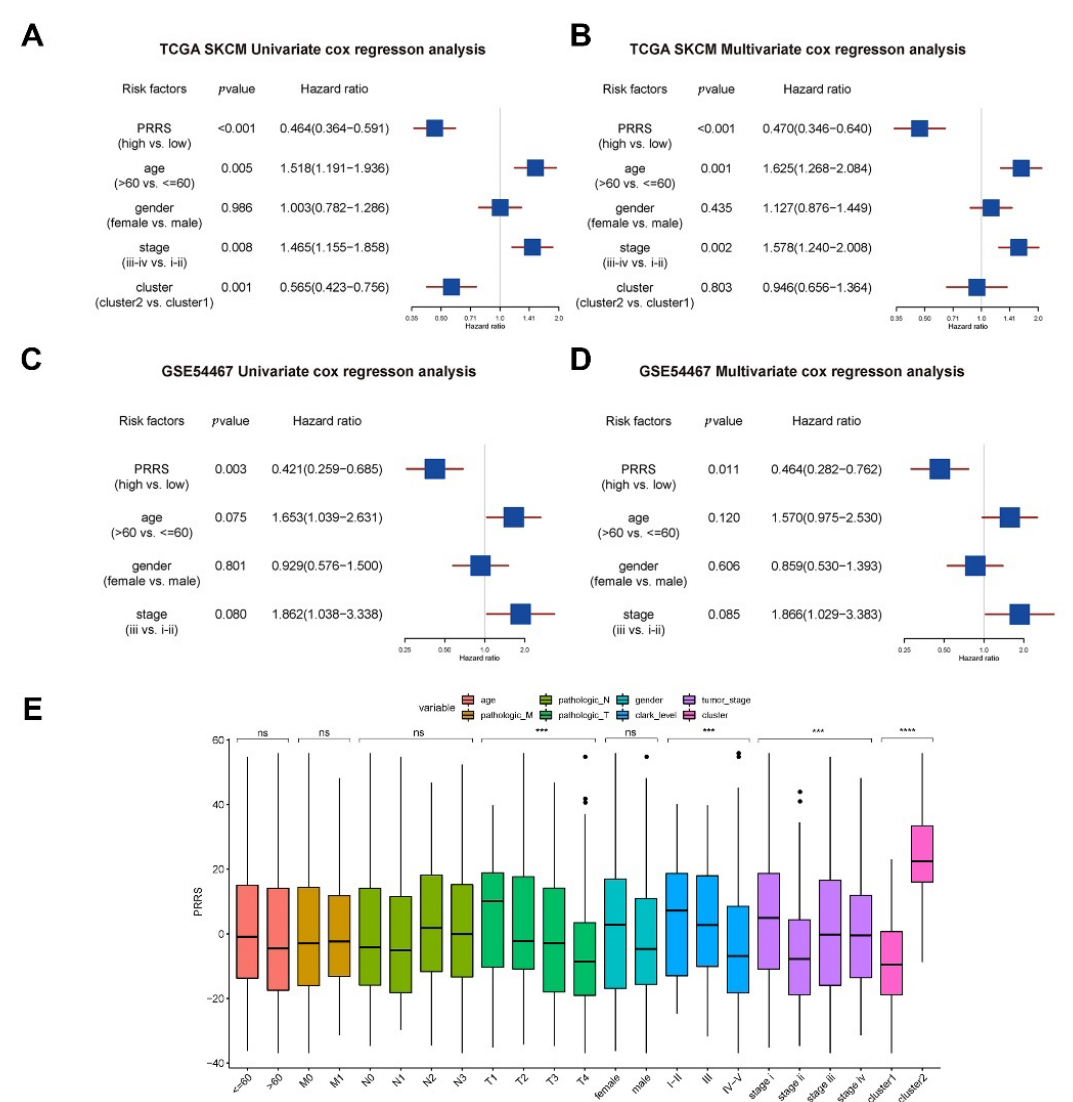
Figure 9. PRRS correlates with tumor prognosis and clinical features. ( A , B ) We used TCGA-SKCM data to verify whether PRRS grouping is an independent prognostic factor. Our results demonstrated that PRRS subgroup ( p < 0.001), age subgroup ( p = 0.005) and stage subgroup ( p = 0.008) had better prognostic efficacy and were independent of each other. ( A ) TCGA-SKCM univariate cox regression analysis. ( B ) TCGA-SKCM multivariate cox regression analysis. ( C , D ) We used GSE54467 data to verify whether PRRS grouping is an independent prognostic factor. Our results demonstrated a better prognostic efficacy for PRRS subgroup grouping ( p = 0.003). ( C ) GSE54467 univariate cox regression analysis. ( D ) GSE54467 multivariate cox regression analysis. ( E ) Differences in PRRS in clinical characteristic groupings (ns, not significant, *** p < 0.001, **** p < 0.0001).